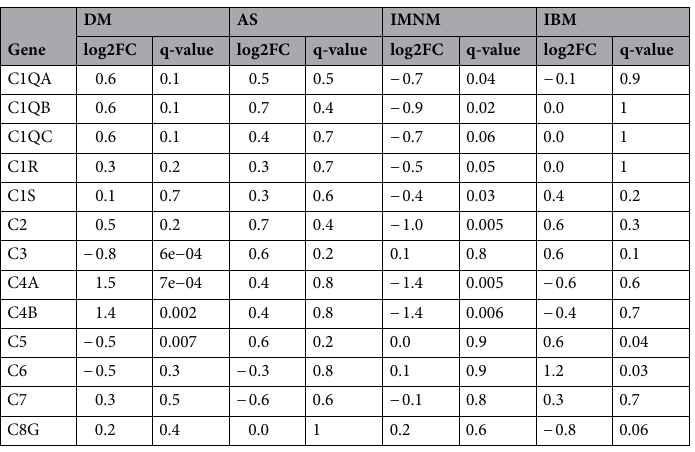
Table 2. Expression of complement genes in each group compared to the other types of inflammatory myopathy. These genes did not pass the cutoff for differential expression: C8A, C8B, C9. DM Dermatomyositis; AS Antisynthetase syndrome; IMNM Immune-mediated necrotizing myositis; IBM Inclusion body myositis.